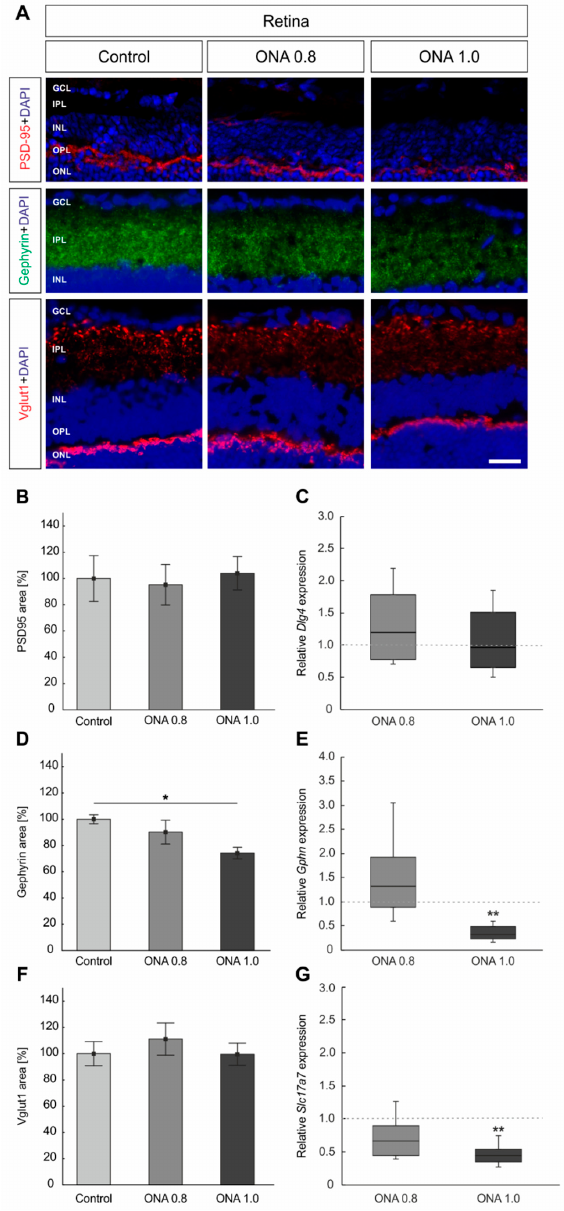
Figure 3. Remodeling of synapses. ( A ) Cross-sections of the retina were stained with antibodies against anti-PSD95 (postsynapses; red), anti-gephyrin (GABAergic synapses; green), and anti-Vglut1 (glutamatergic synapses; red). ( B ) No alterations were noted in PSD95 + area in both immunized groups compared to control animals ( p > 0.05). ( C ) Furthermore, the mRNA expression levels of Dlg4 (Psd95) were not altered ( p > 0.05). ( D ) The gephyrin area showed no changes in ONA 0.8 animals compared to controls ( p > 0.05). In contrast, a significant decrease of gephyrin signal was observed in ONA 1.0 retinas ( p = 0.02). ( E ) The RT-qPCR analyses of Gphn showed no di ff erences in the ONA 0.8 animals ( p > 0.05). However, a significant downregulation of Gphn mRNA was noted in ONA 1.0 retinas ( p = 0.008). ( F ) The Vglut1 + staining area remained unaltered in both ONA immunized groups ( p > 0.05). ( G ) The mRNA expression of Slc17a7 did not changed in the ONA 0.8 group ( p > 0.05). In ONA 1.0 retinas, a significant downregulation of Slc17a7 mRNA could be noted ( p = 0.009). Abbreviations: GCL = ganglion cell layer, IPL = inner plexiform layer, INL = inner nuclear layer, OPL = outer plexiform layer, ONL = outer nuclear layer. The dotted line in C, E, and G represents the relative expression level of the control group. Values are mean ± SEM for immunohistology and median ± quartile + maximum / minimum for RT-qPCR. Scale bar: 20 µ m. * p < 0.05, ** p <